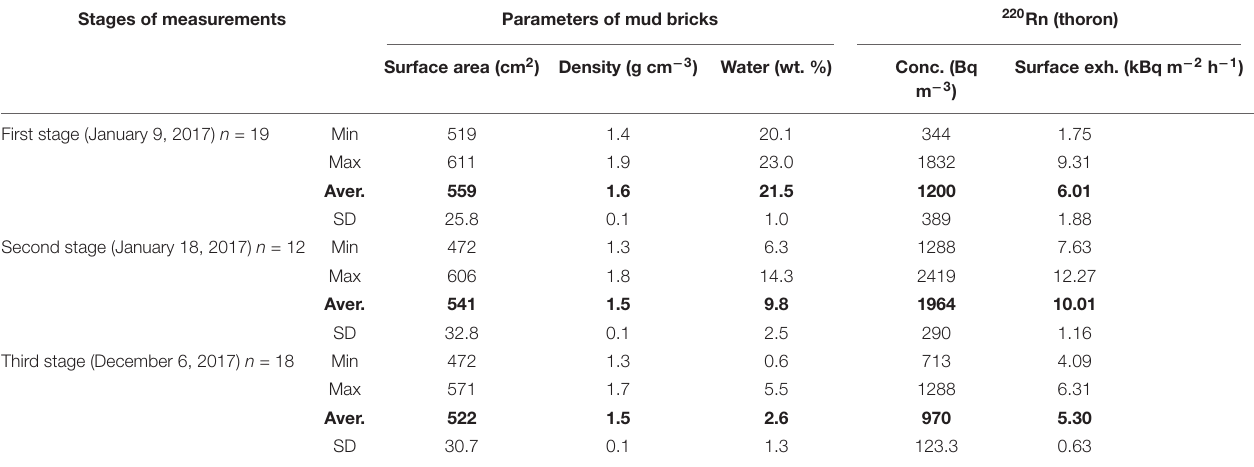
TABLE 1 | Surface area (cm 2 ), bulk density (g cm − 3 ), and water content (wt. %) of cuboid-shaped mud bricks after air-drying through three experimental stages, and 220 Rn (thoron) concentrations (Conc.) and surface exhalation rates (Surface exh.) of mud bricks in the polyethylene chamber. Stages of